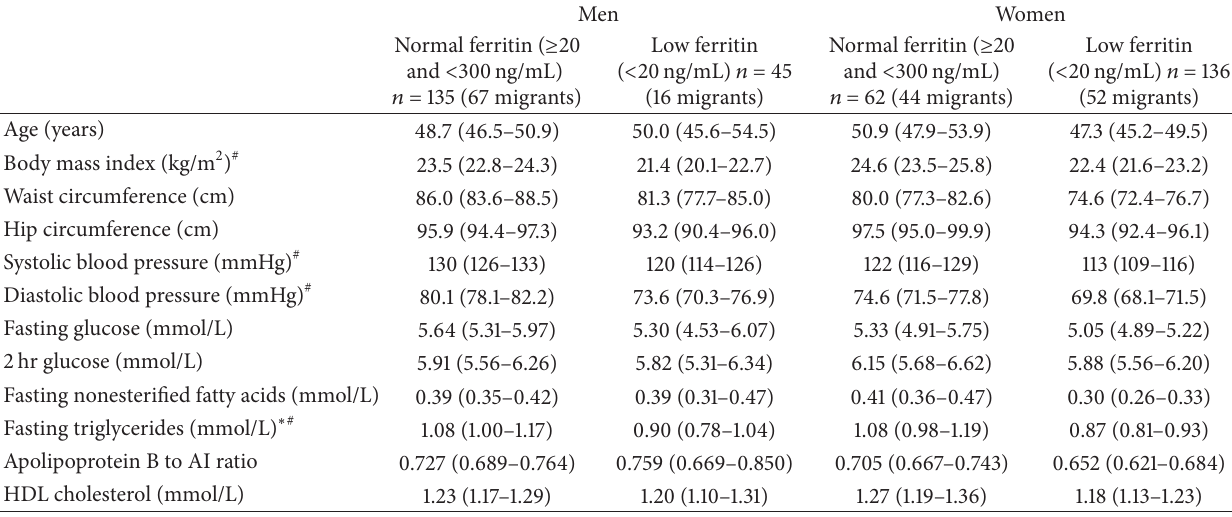
Table 1: Diabetes related indices by body iron status amongst Indian Gujaratis.